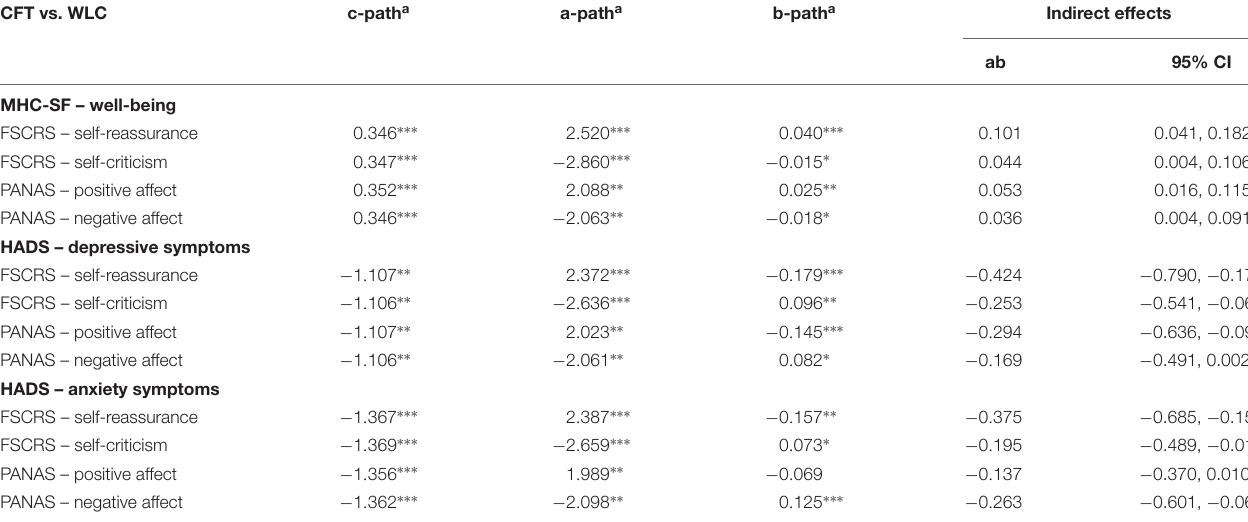
TABLE 4 | Outcomes of simple mediation models assessing indirect effects of mediators on changes in well-being, depressive symptoms and anxiety symptoms compared to the waitlist control condition. CFT vs.